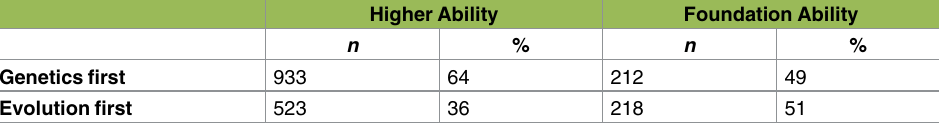
Table 3. Proportions of higher- ( n = 1,456) and foundation- ( n = 430) ability students taught genetics first and evolution first. Raw data can be found in S1 and S2 Data.